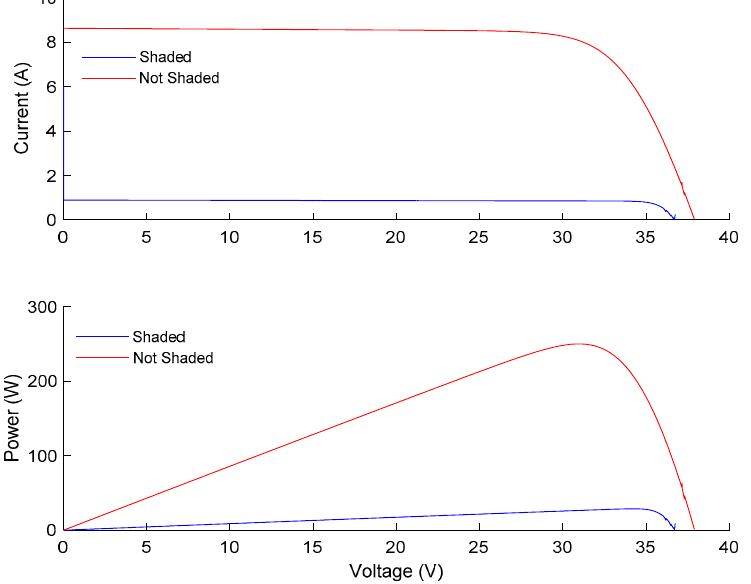
Figure 1. I-V and P-V curve of a PV module when cells are shaded without bypass diodes.